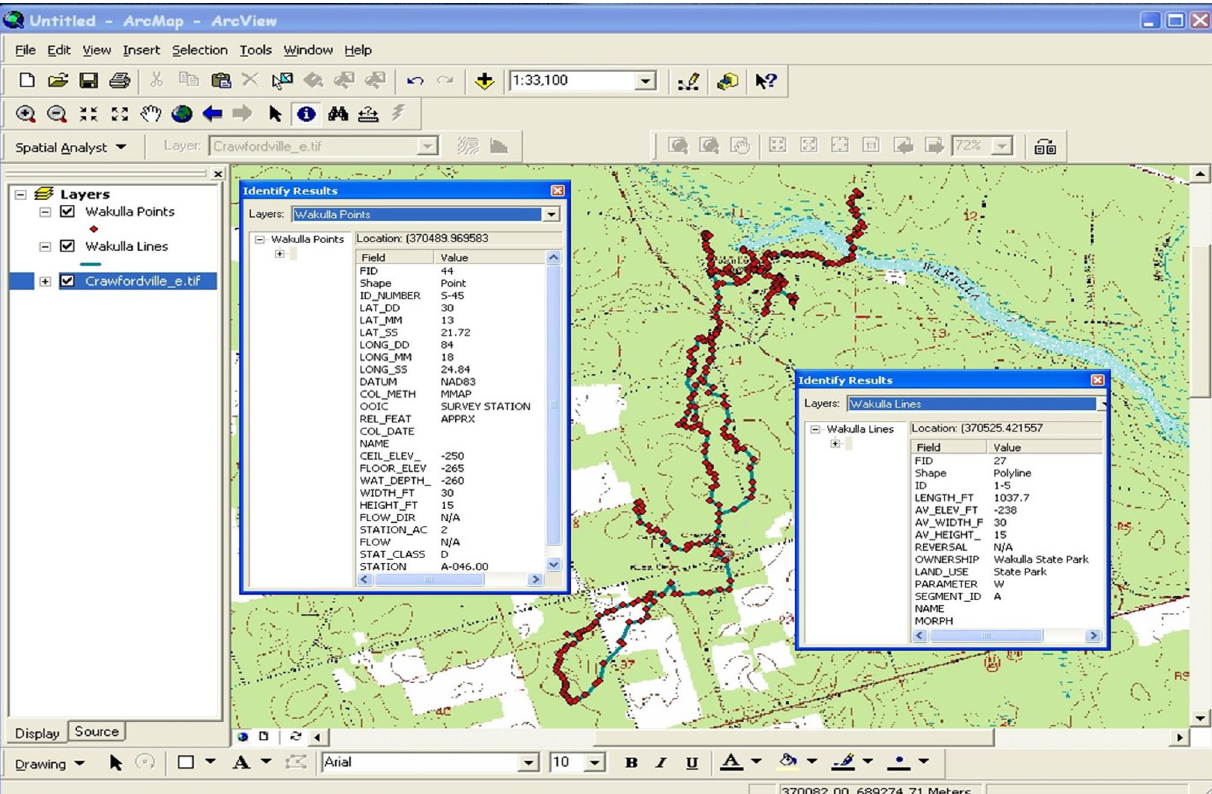
Fig. 3 Wakulla cave passage